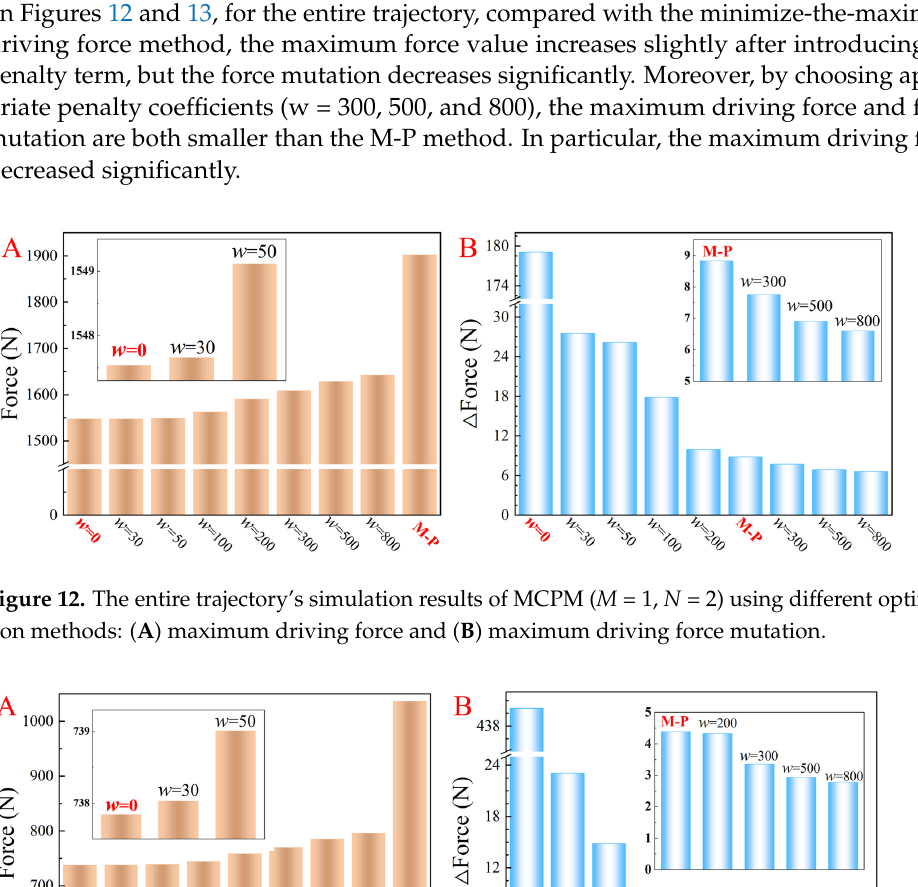
Figure 11. Driving force mutation of MCPM ( M = 2, N = 2) using different optimization methods: